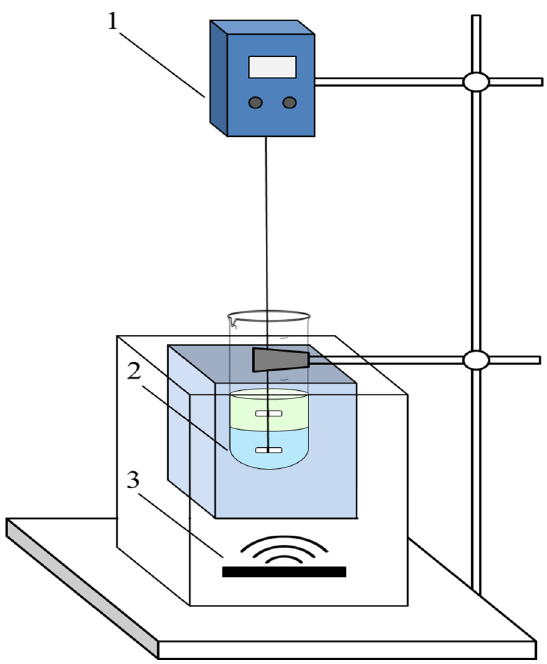
Figure 3. Experimental setup: 1—top-driven stirrer; 2—extraction system; 3—ultrasonic generator.